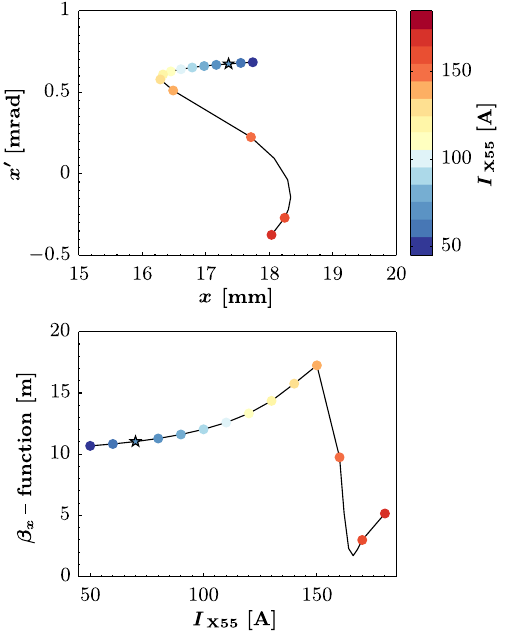
FIG. 18. Simulated dependency of the position of the SFP (top) and of the β x -function (bottom) on the current of X55. In bothcases the figures describe the situation for the external island at the location of SMH16. The initial values are indicated by the